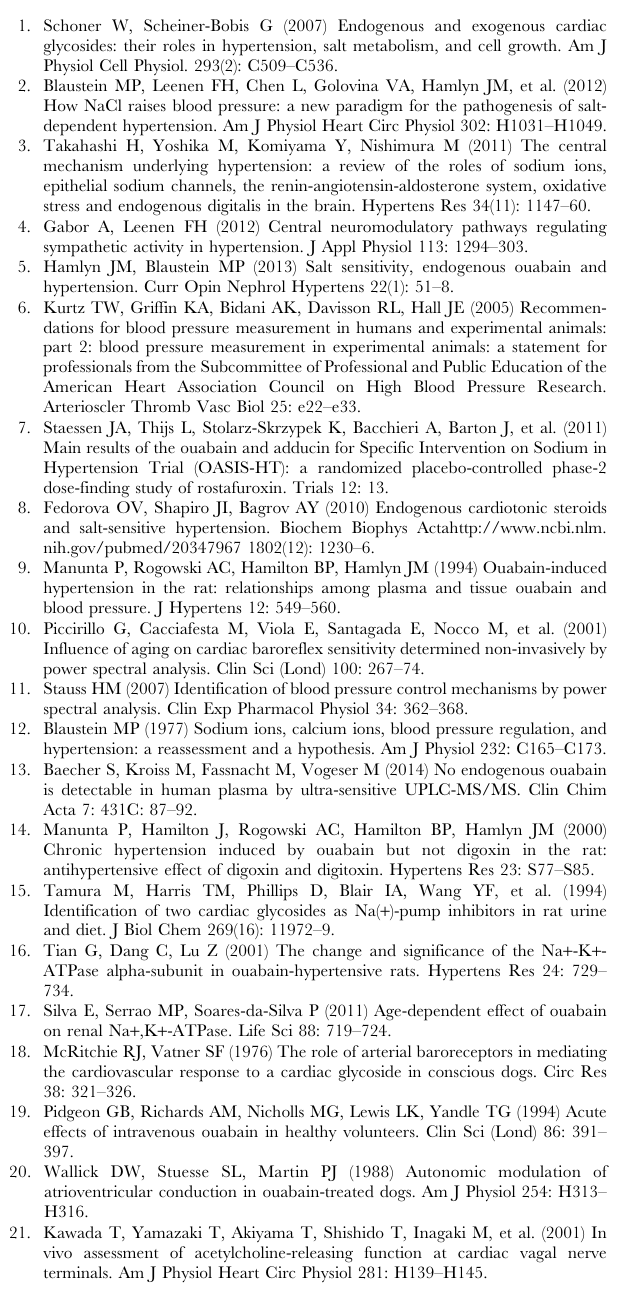
Table S9 Complexity and self-similarity of systolic pressure variability. (PDF) Table S10 Hemodynamic responses to restraint stress (MANOVA results). (PDF) Table S11 Blood pressure and heart rate variability responses to restraint stress (MANOVA results). (PDF) Methods S1 Detailed description of the experimental procedures.